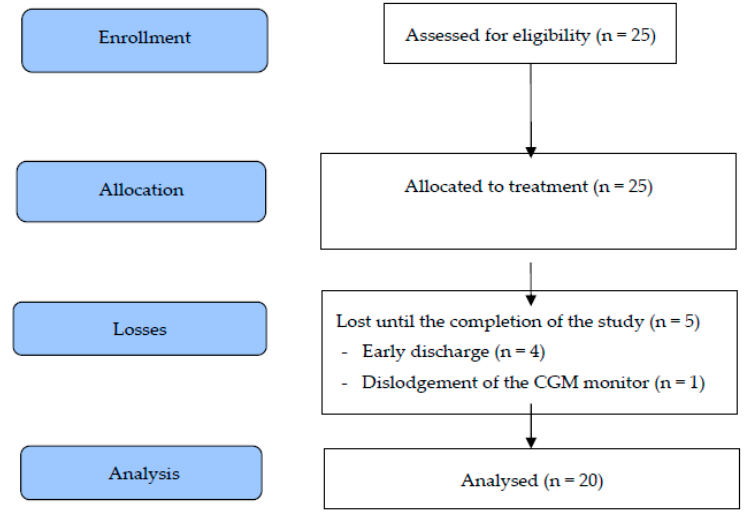
Figure 1. Flow diagram of study participants. CGM, continuous glucose monitoring.